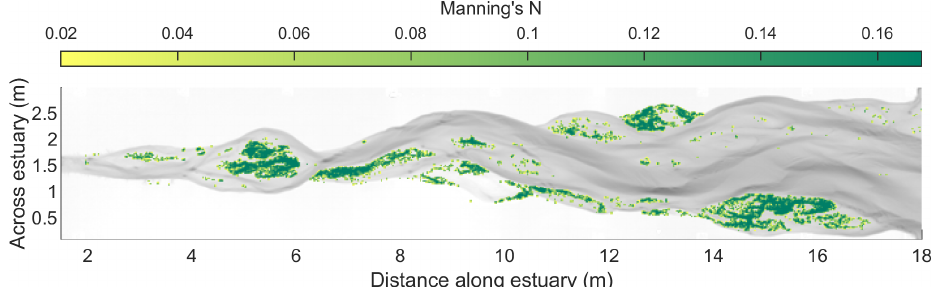
Figure 7. Example of Manning roughness values for the vegetated estuary specified as initial condition in the Nays2D flow model at 13000 tidal cycles. The Manning roughness of the unvegetated bed is set to 0.02 in the model.